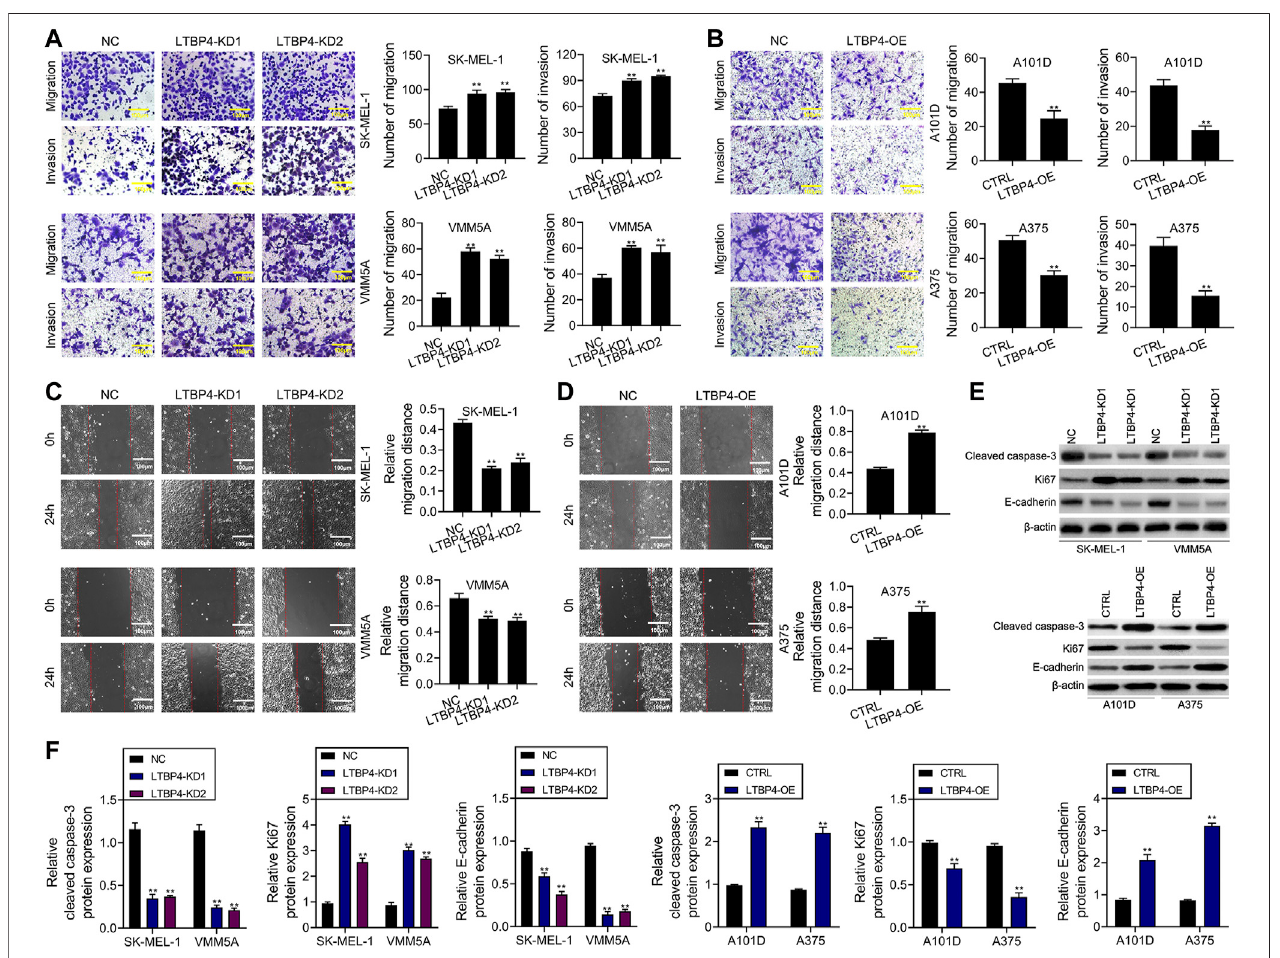
FIGURE 4 | LTBP4 signi fi cantly regulated the invasion and migration in melanoma cell lines, and closely related tothe expressions ofcleaved caspase-3, Ki67 and E-cadherin. (A) The migration and invasion of shRNA-LTBP4#1 or #2 transfected SK-MEL-1 and VMM5A cells was detected by transwell assay. (B) The migration and invasionofLTBP4expressingplasmidstransfectedA101DandA375cellswasdetectedbytranswellassay. (C) ThemigrationofshRNA-LTBP4#1or#2transfectedSK- MEL-1 and VMM5A cells was detected by transwell assay. (D) The migration of LTBP4 expressing plasmids transfected A101D and A375 cells was detected by wound healing assay (E and F) The protein levels of cleaved caspase-3, Ki67, and E-cadherin in shRNA-LTBP4#1 or #2 transfected SK-MEL-1 and VMM5A cells or LTBP4 expressing plasmids transfected A101D and A375 cells were detected by western blotting assay. β -actin was used as a load control. Data are presented as the mean ± standard deviation. ** p < 0.01 vs NC/CTRL